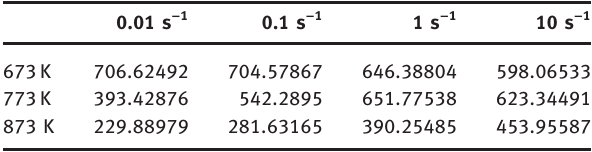
Table 6: f 3 ð _ ε , T Þ value under different temperatures and strain rates. Table 5: f 2 ð _ ε , T Þ value under different temperatures and strain